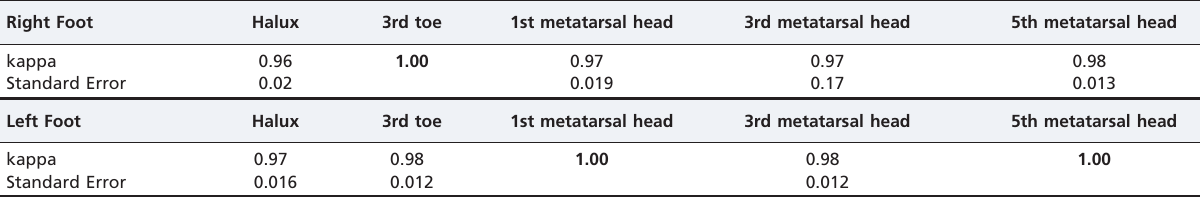
Table 2 - Correlation coefficients for the sites